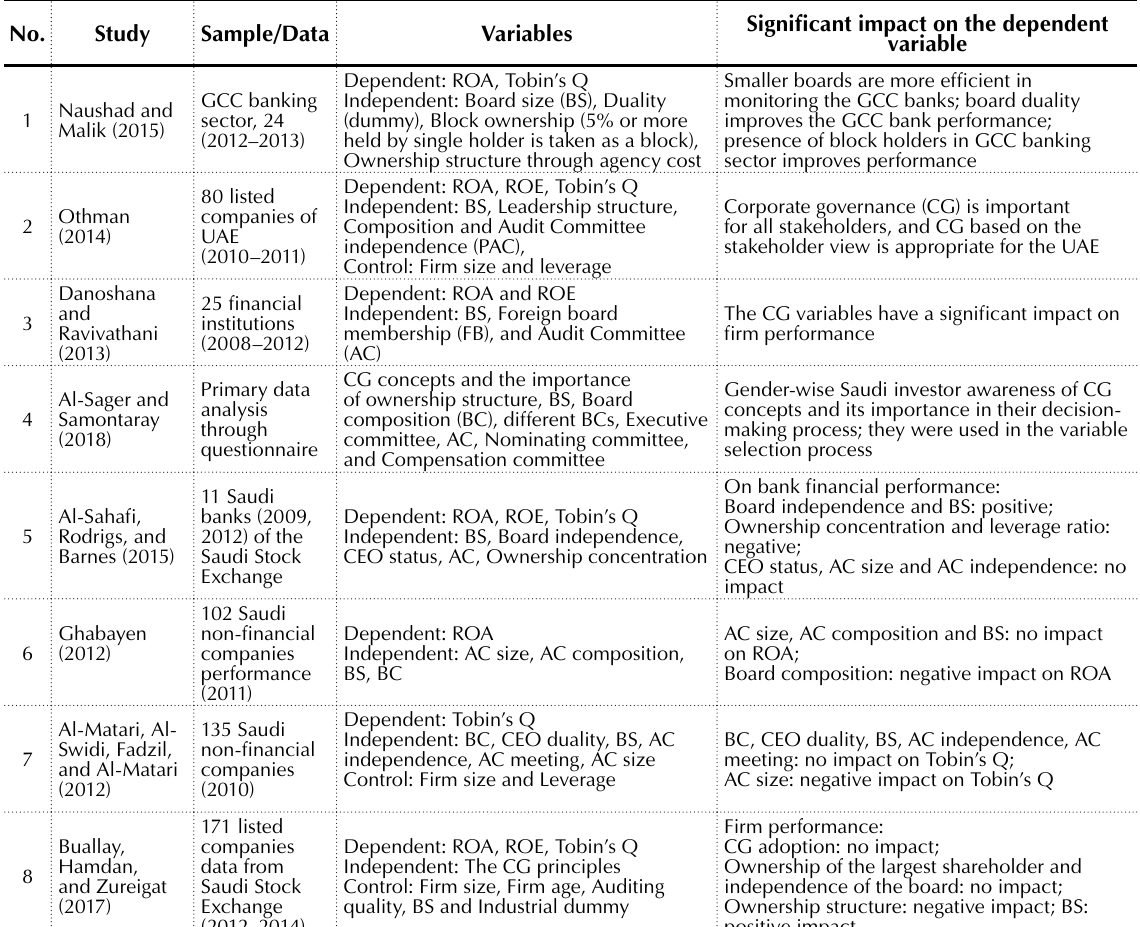
Table 1. Summary of the literature